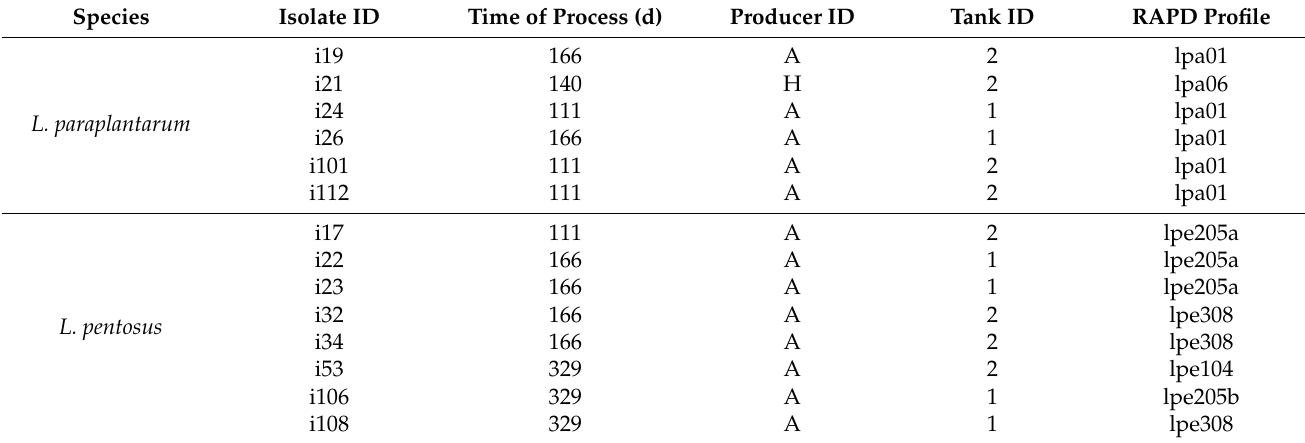
Table 1. Identification of native strains isolated from Cobrançosa table